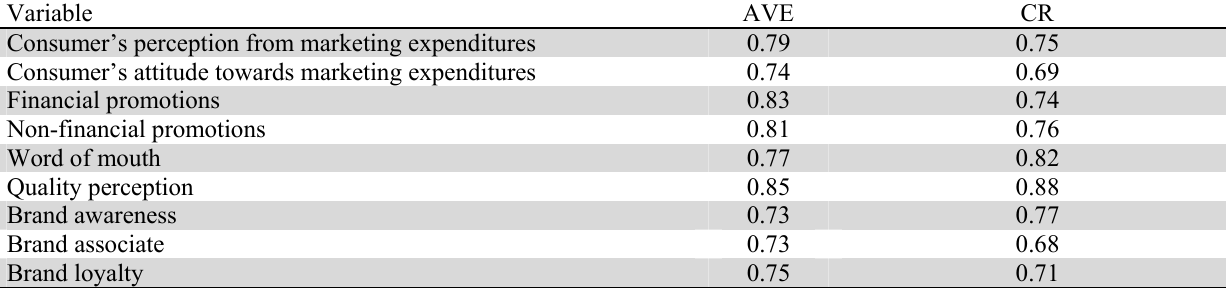
The summary of Cronbach alpha